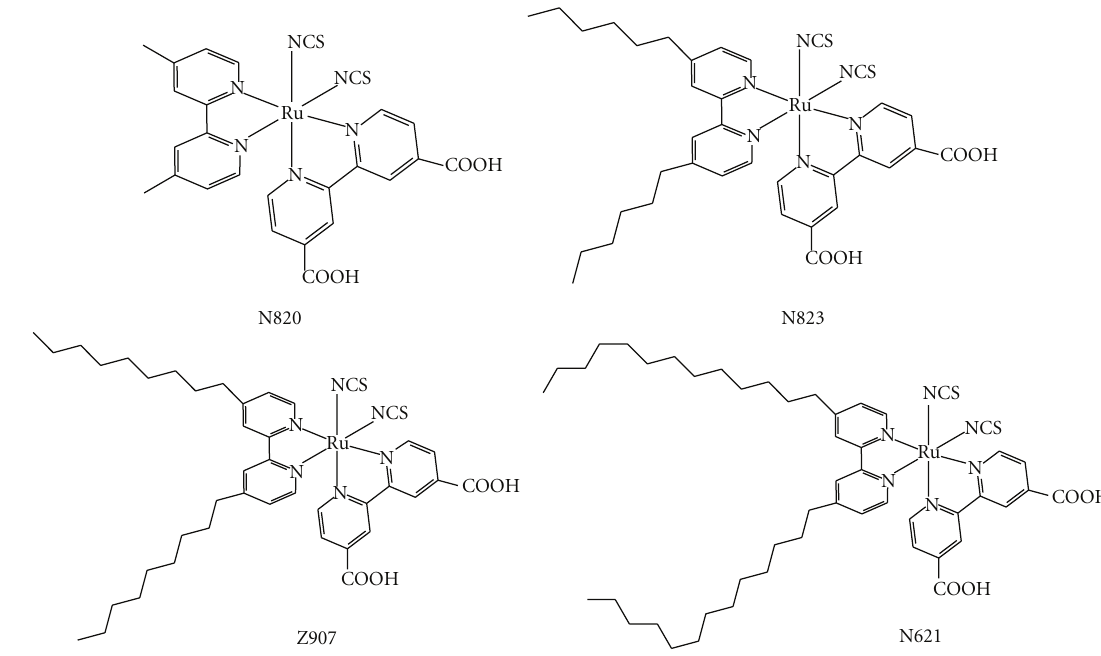
Figure 6: Heteroleptic dyes used in conjunction to cobalt electron transfer